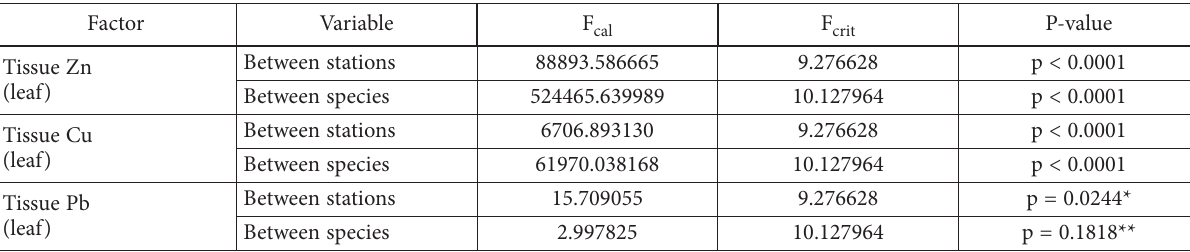
Table 6. ANOVA of heavy metal concentrations in the leaf samples between stations and between species Factor